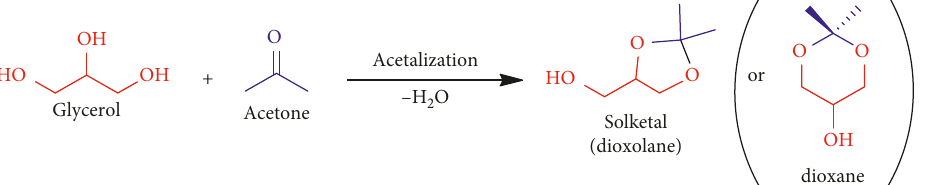
Scheme 1: Synthesis of solketal from bioglycerol.